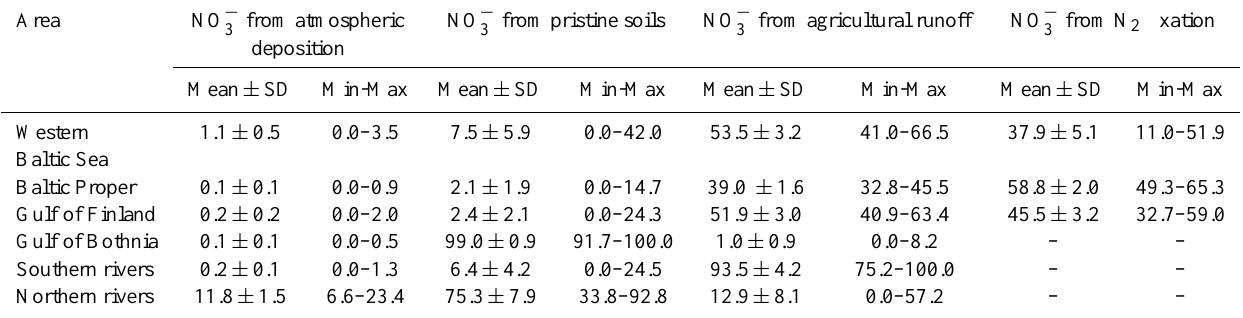
Table 3. Source attribution results: Mean, standard deviation, and minimum and maximum values for the potential contributions of four potential NO − sources for the areas Western Baltic Sea, Baltic Proper, Gulf of Finland, Gulf of Bothnia, southern rivers, and northern rivers. 3 Area